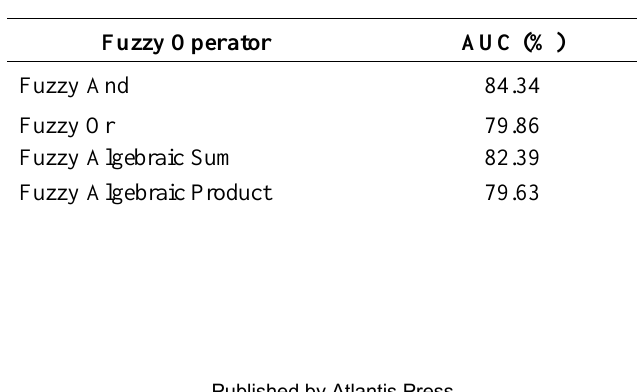
Table 3. Verification results using Receiver Operating Characteristic (ROC) and Area Under Curve